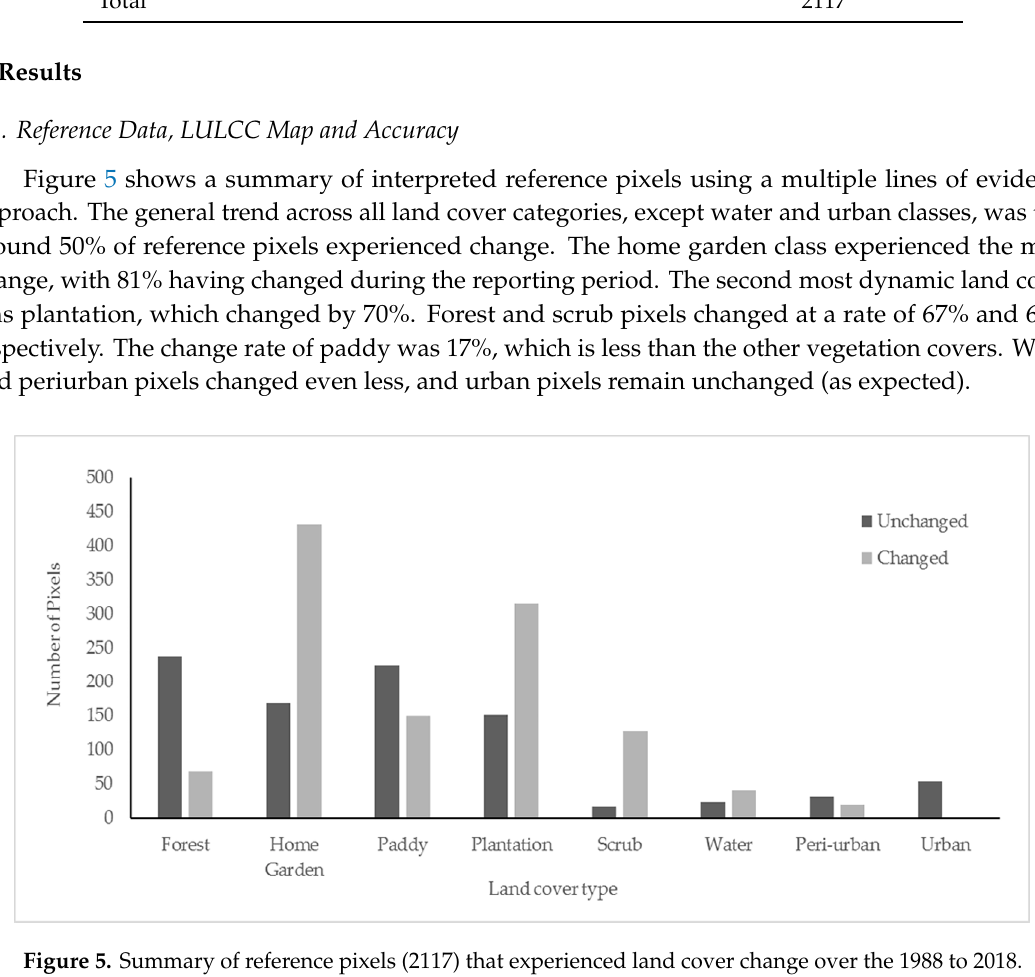
Table 2. Distribution of sample pixels according to di ff erent land cover classes.